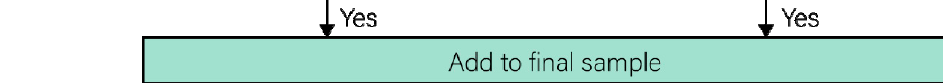
Figure 2. The screening process used to filter irrelevant literature.